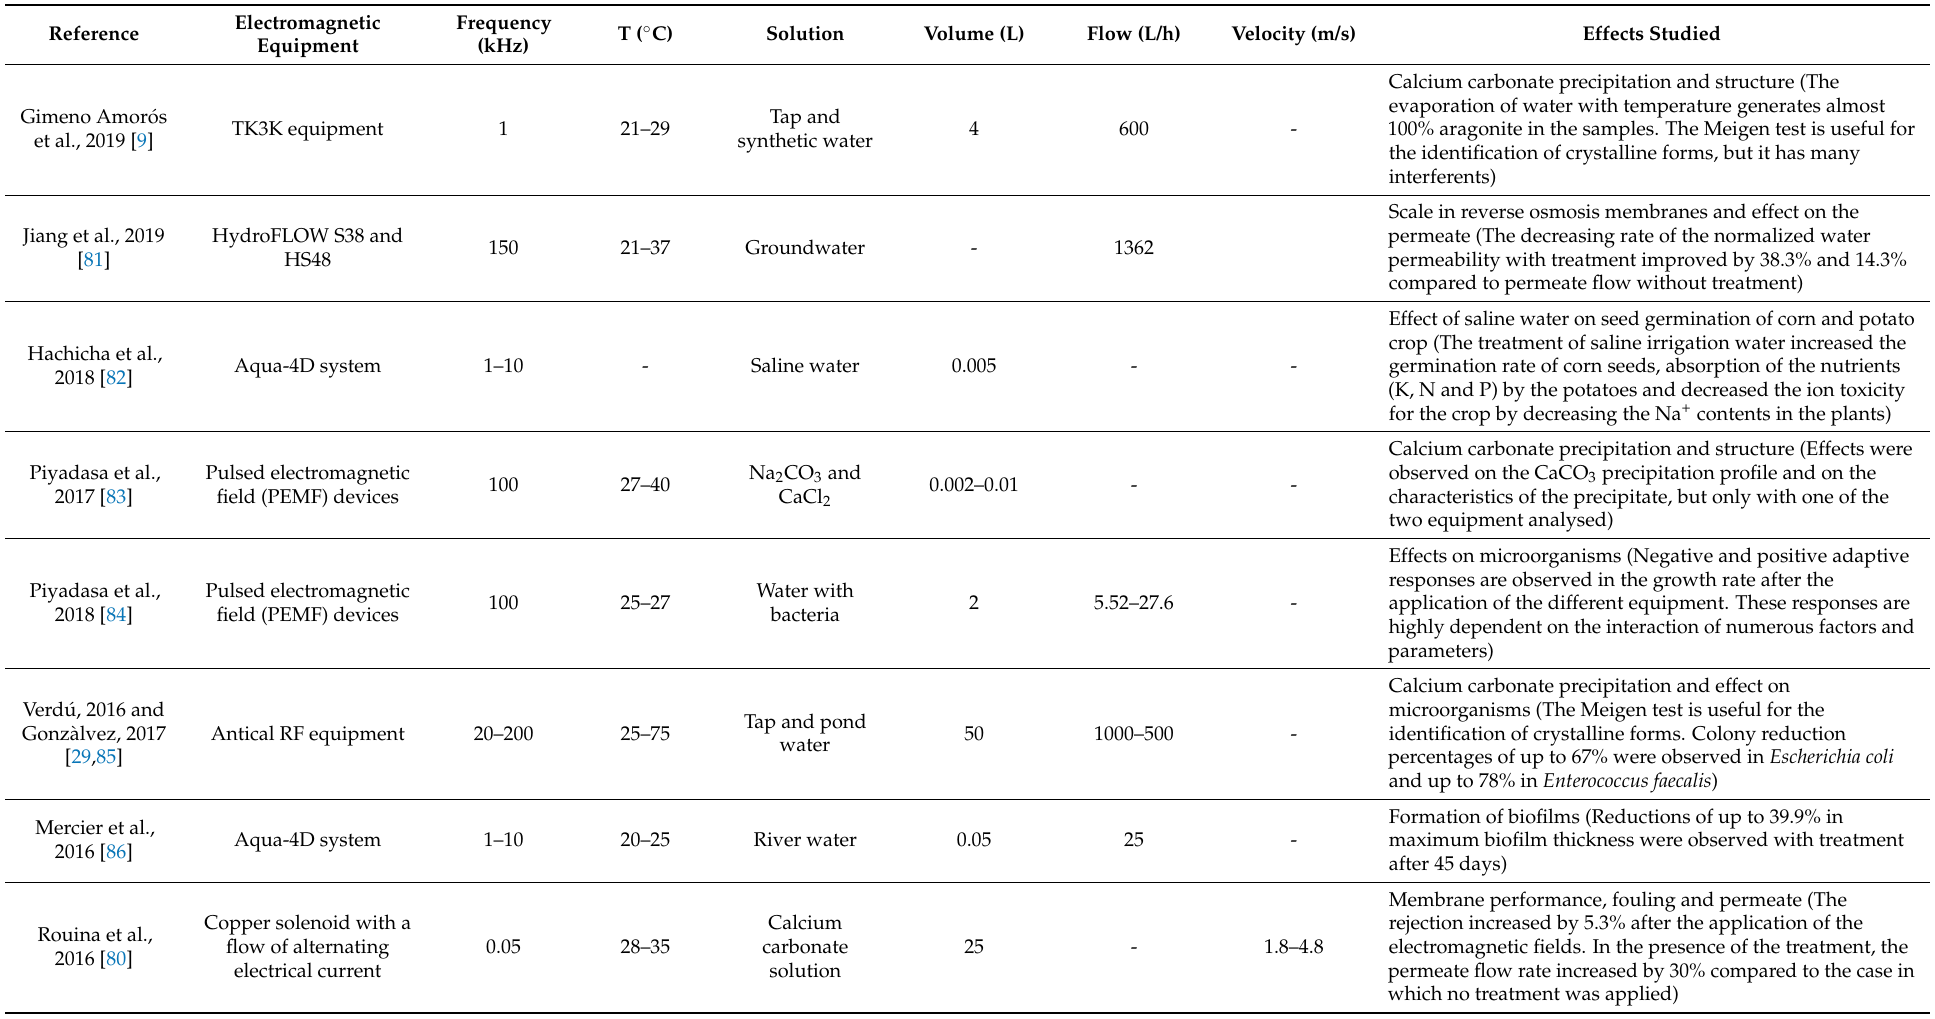
Table 4. Electromagnetic equipment used in the literature (own